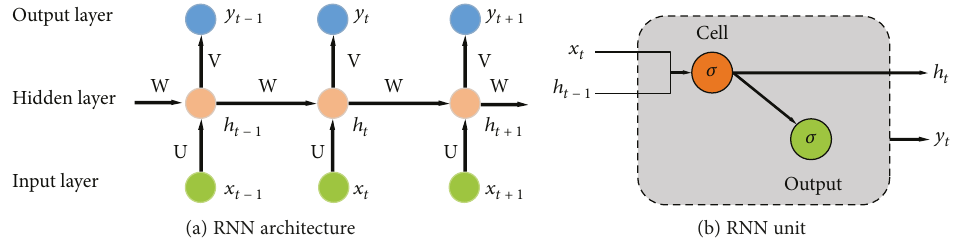
Figure 1: Recurrent neural networks.